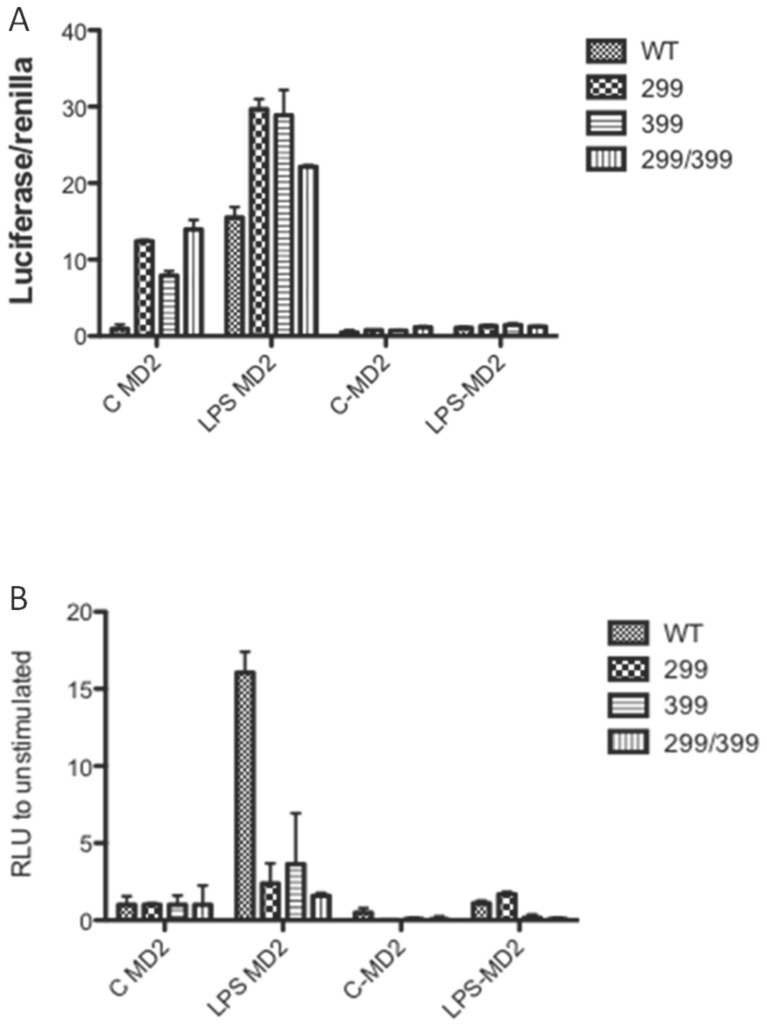
Transient transfection of TLR4 Asp299Gly, TLR4 Thr399Ile or TLR4 Asp299Gly/Thr399Ile with MD2 into HEK cells results in constitutive NF-κB activation but a reduced relative increase compared to basal NF-κB activity.HEK cells were transiently transfected with wild-type or mutant TLR4 +MD-2 +CD14, together with the reporter constructs NF-κB-luc and Renilla luciferase. After 48 h the cells were stimulated for 6 h with medium alone (C) or medium +10 ng/ml LPS (LPS) and the luciferase activity was determined in cell lysates. Data are from a representative experiment (n = 3 experiments) and are shown as mean ±SEM for that experiment. A) Relative luciferase activity of wild type TLR4, Asp299Gly TLR4, Thr399Ile TLR4 or Asp299Gly/Thr399Ile TLR4 with or without stimulation with 10 ng/ml LPS. B) Fold increase in luciferase activity compared to basal activity induced by stimulation of wild type TLR4, Asp299Gly TLR4, Thr399Ile TLR4 or Asp299Gly/Thr399Ile TLR4 with 10 ng/ml LPS. C MD2  =  unstimulated cells in the presence of MD2; LPS MD2  =  LPS stimulated cells in the presence of MD2; C-MD2  =  unstimulated cells with MD2 absent; LPS-MD2  =  LPS stimulated cells with MD2 absent.